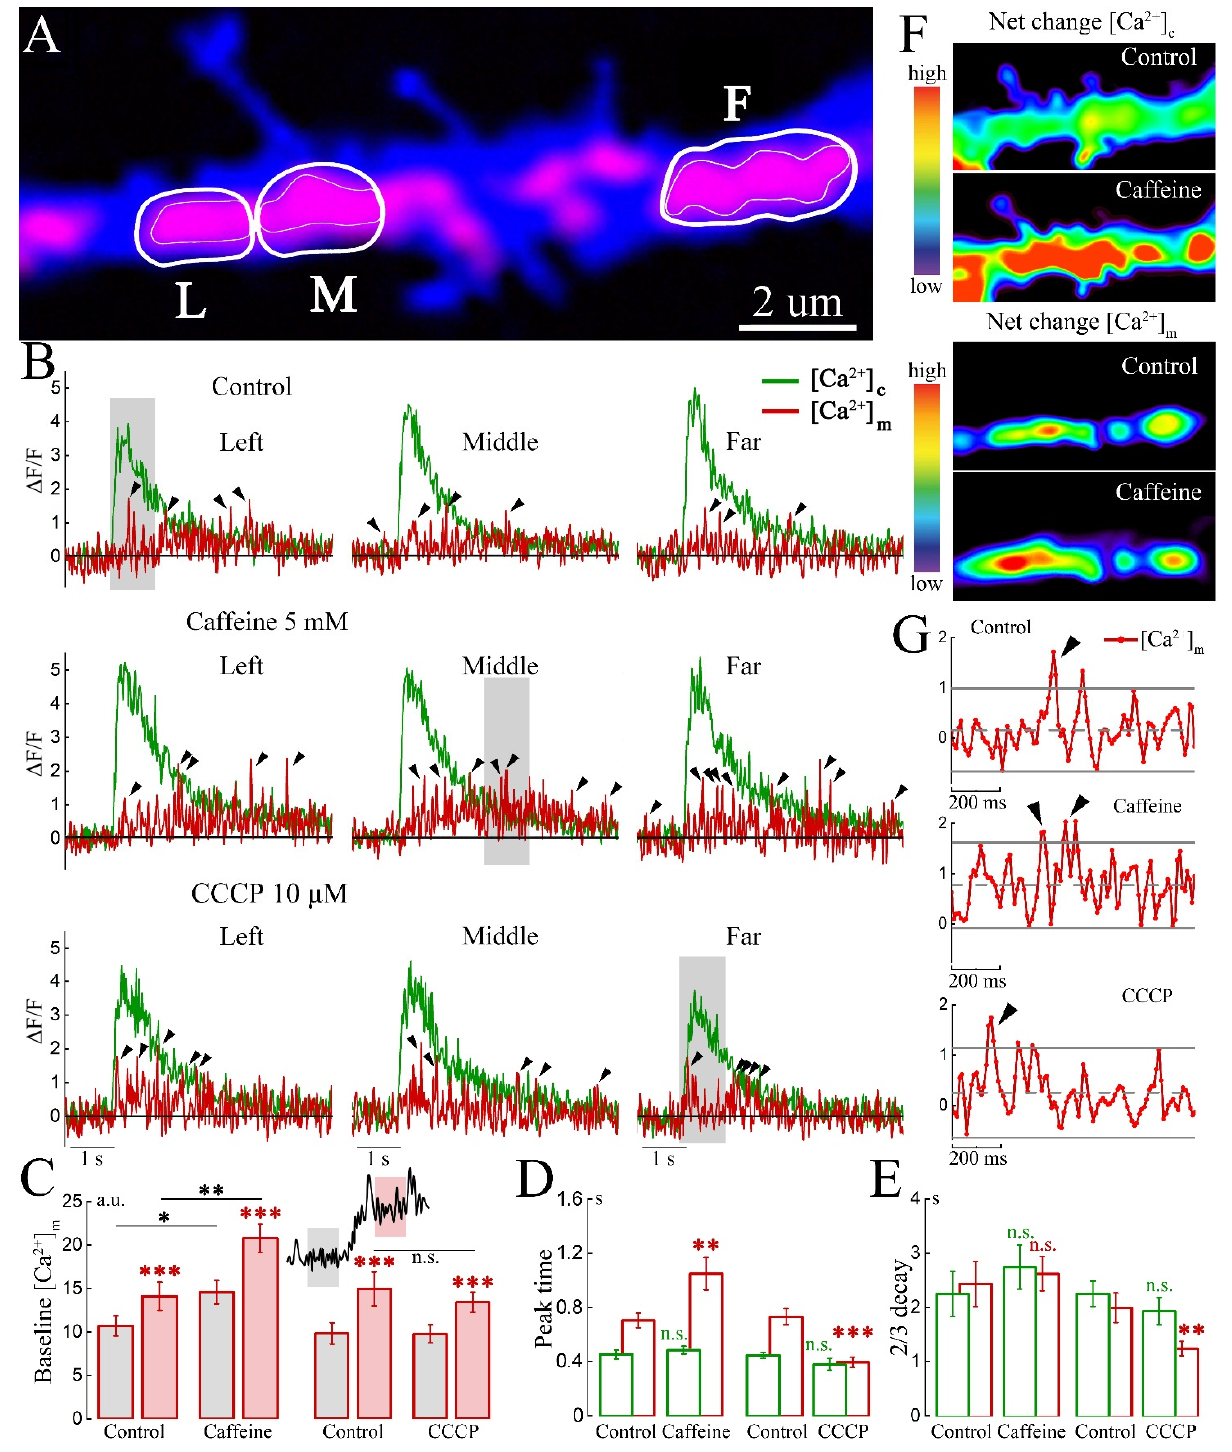
Figure 2. Spontaneous global cytosolic calcium events are reflected in dendritic mitochondrial calcium transients. ( A ) MT clusters (red, mtRCaMP, [Ca 2+ ]m) are marked by thin white boundaries, designate left (L), middle (M), and far (F) mitochondrial regions in the dendrite (blue, eBFP). The corresponding cytosolic calcium ([Ca 2+ ]c) regions (left, middle and far) are emphasized by thicker white boundaries. The dendritic segment is the same as in Figure 1A. ( B ) Top: plots of [Ca 2+ ]c in dendritic regions (green) and [Ca 2+ ]m (red) were made as in panel ( A ). Both, [Ca 2+ ]c and [Ca 2+ ]m in all regions were the same within the central cluster and in the far one. The same was seen in caffeine (middle) and CCCP (bottom) panels. Note the presence of spikelets, marked by arrowheads,